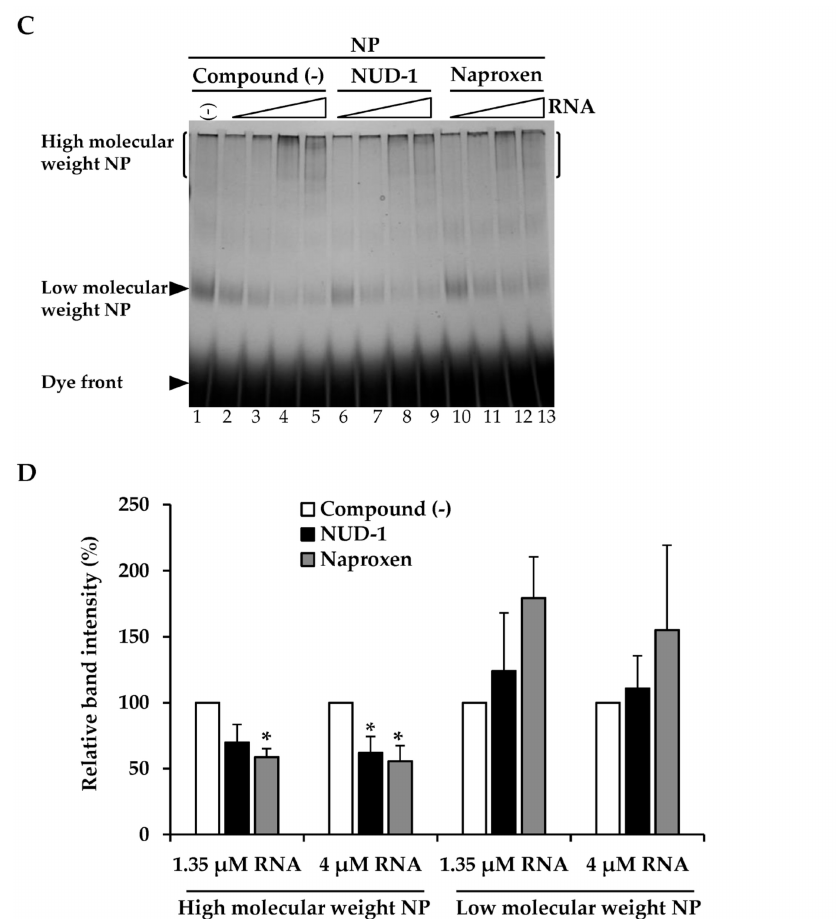
Figure 1. E ff ects of NUD-1 and naproxen on nucleoprotein (NP) oligomerization. ( A ) Purified recombinant NP was analyzed using 10% SDS-PAGE followed by Coomassie brilliant blue staining. ( B ) The migration of protein markers (thyroglobulin, 669 kDa; apoferritin, 443 kDa; β -amylase, 200 kDa) and NP mixed with yeast (0.05, 0.15, 0.45, 1.35, and 4 µ M) was analyzed using blue native polyacrylamide gel electrophoresis (BN-PAGE). ( C ) NP (2.5 µ M, equivalent to 2 µ g) was mixed with RNA (0.15, 0.45, 1.35, and 4 µ M) in the absence of any compound or in the presence of 100 µ M NUD-1 or naproxen and incubated at room temperature overnight before analysis via BN-PAGE. The intensity of the smear at the top of the gel (enclosed by bracket) was quantified using ImageJ software. The relative band intensity in the presence of NUD-1 or naproxen was calculated in reference to that in the absence of a compound. Three independent experiments were performed, and representative data are shown. ( D ) The relative band intensities of high-molecular-weight and low-molecular-weight NP treated with 1.35 µ M RNA (no compound, lane 4; NUD-1, lane 8; naproxen, lane 12), and NP treated with 4 µ M RNA (no compound, lane 5; NUD-1, lane 9; naproxen, lane 13) were quantified from three independent experiments. The asterisk indicates p <